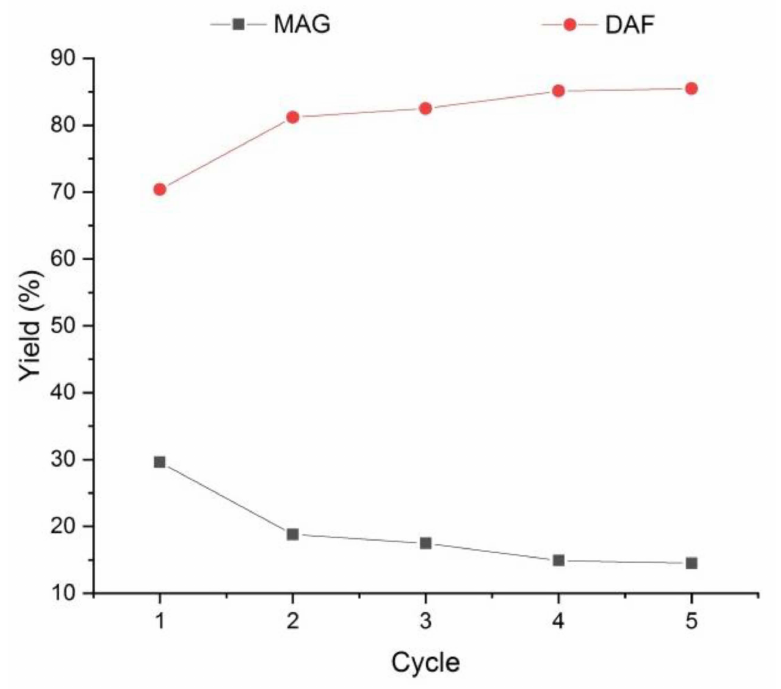
Figure 4. Conversion of MAG to DAF through iterative isomerization and esterification.